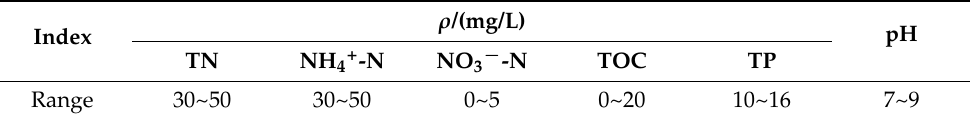
Table 1. Water quality of influent wastewater.